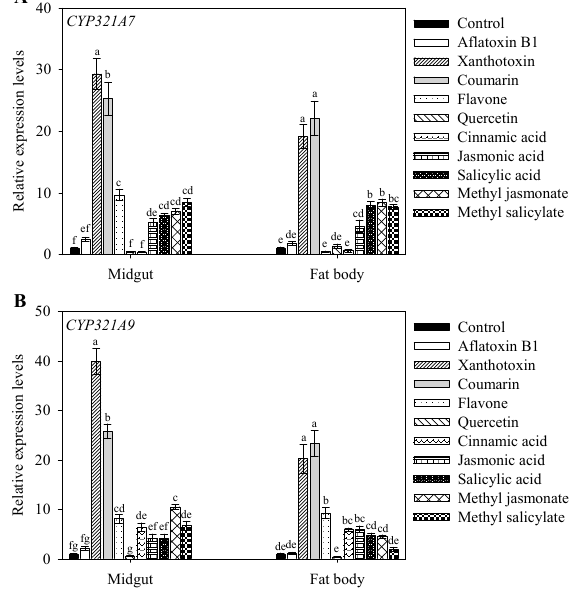
Figure 5. Expression levels of CYP321A7 ( A ) and CYP321A9 ( B ) in Spodoptera litura after feeding fourth instar larvae with a diet containing different allelochemicals. The larvae were reared on a diet without allelochemicals (control) or on different diets containing 1.0 μ g·g − 1 aflatoxin B1, 0.25 mg·g − 1 xanthotoxin, 1.0 mg·g − 1 coumarin, 1.0 mg·g − 1 flavone, 1.0 mg·g − 1 quercetin, 1.0 mg·g − 1 cinnamic acid, 2.9 μ g·g − 1 jasmonic acid, 12.0 μ g·g − 1 salicylic acid, 2.9 μ g·g − 1 methyl jasmonate or 12.0 μ g·g − 1 methyl salicylate. RNA from midguts and fat bodies was extracted after the larvae had consumed the diet for 48 h. RT-qPCR analysis was used to determine the relative expression levels of CYP321A7 and CYP321A9 . The β -actin gene served as an internal reference. Data shown are means ± SE (three biological replicates). Different letters above bars indicate significant differences ( p < 0.05) according to the Duncan’s multiple range